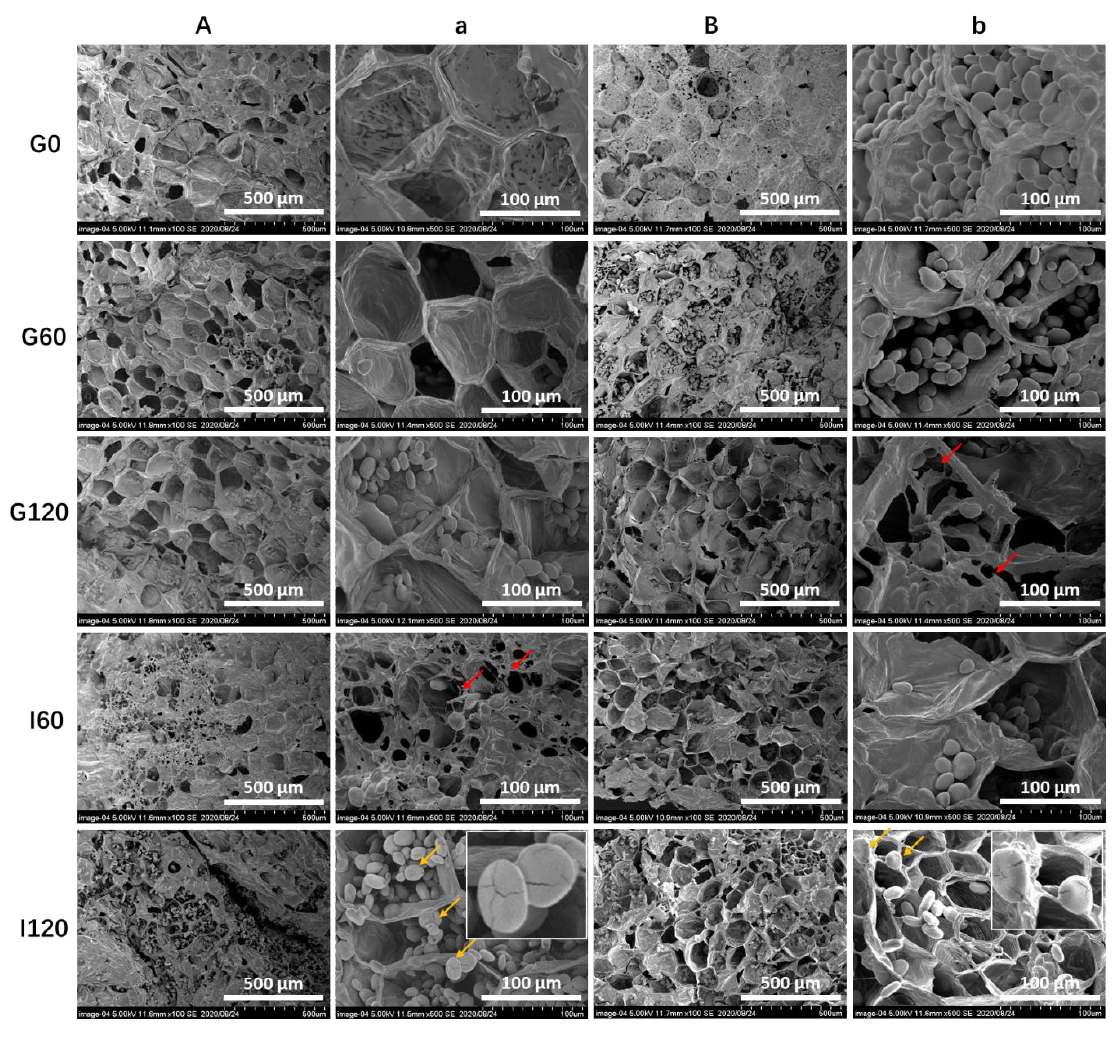
Figure 5. SEM micrographs showing microstructures of raw yam tubers (( A , a ): Nagaimo N-10; ( B , b ): Nebaristar) during in vitro digestion. All the samples with the same raw letter were collected at the same time during digestion (G0/G60/G120: 0, 60 and 120 min during simulated gastric digestion; I60/I120: 60 and 120 min during simulated intestinal digestion). The micrographs for the ( A , B ) columns show the microstructure of samples at the magnification of 100×, and the a and b columns indicate the microstructures at 500× magnification.